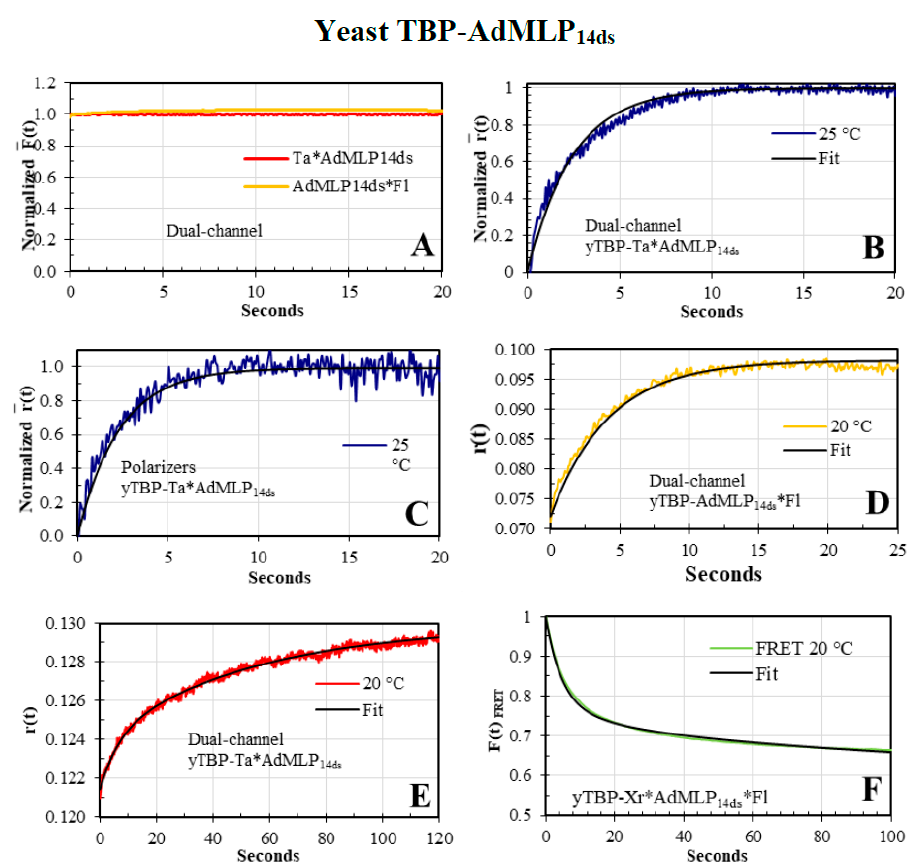
Figure 8. Yeast TBP-AdMLP 14ds association kinetics. ( A ) The dual-channel F ( t ) traces of yTBP (500